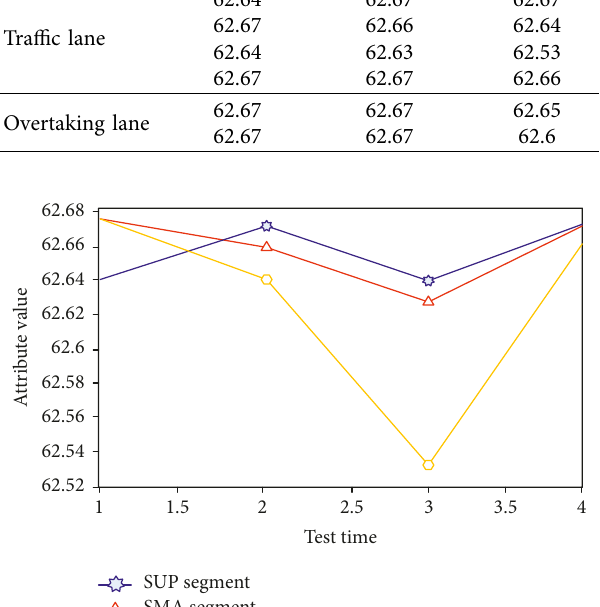
Figure 1: PCI indicators.